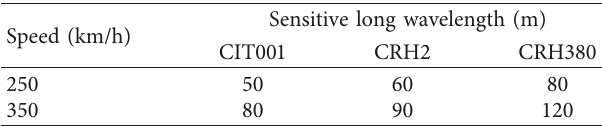
management amplitude of track longitudinal-level irregularities.